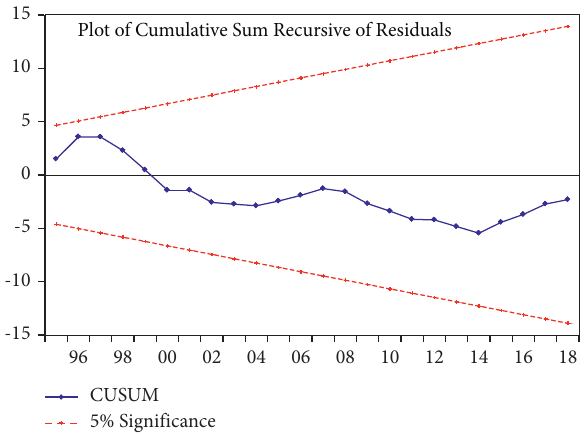
Figure 2: Model stability